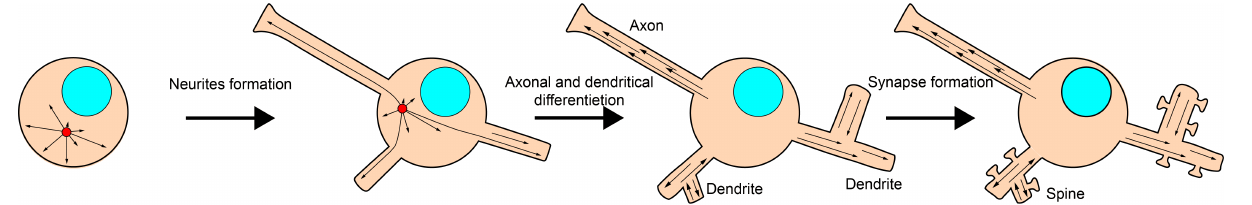
Figure 2. MT changes during neuronal development. After their final division, neurons transit through many developmental stages and the MT cytoskeleton has a crucial role at all the different stages. The MT cytoskeletal organization changes from a radially centrosome-based with largely plus-end out-oriented network to an acentrosomal network with uniform orientations in the axon and mixed orientation in